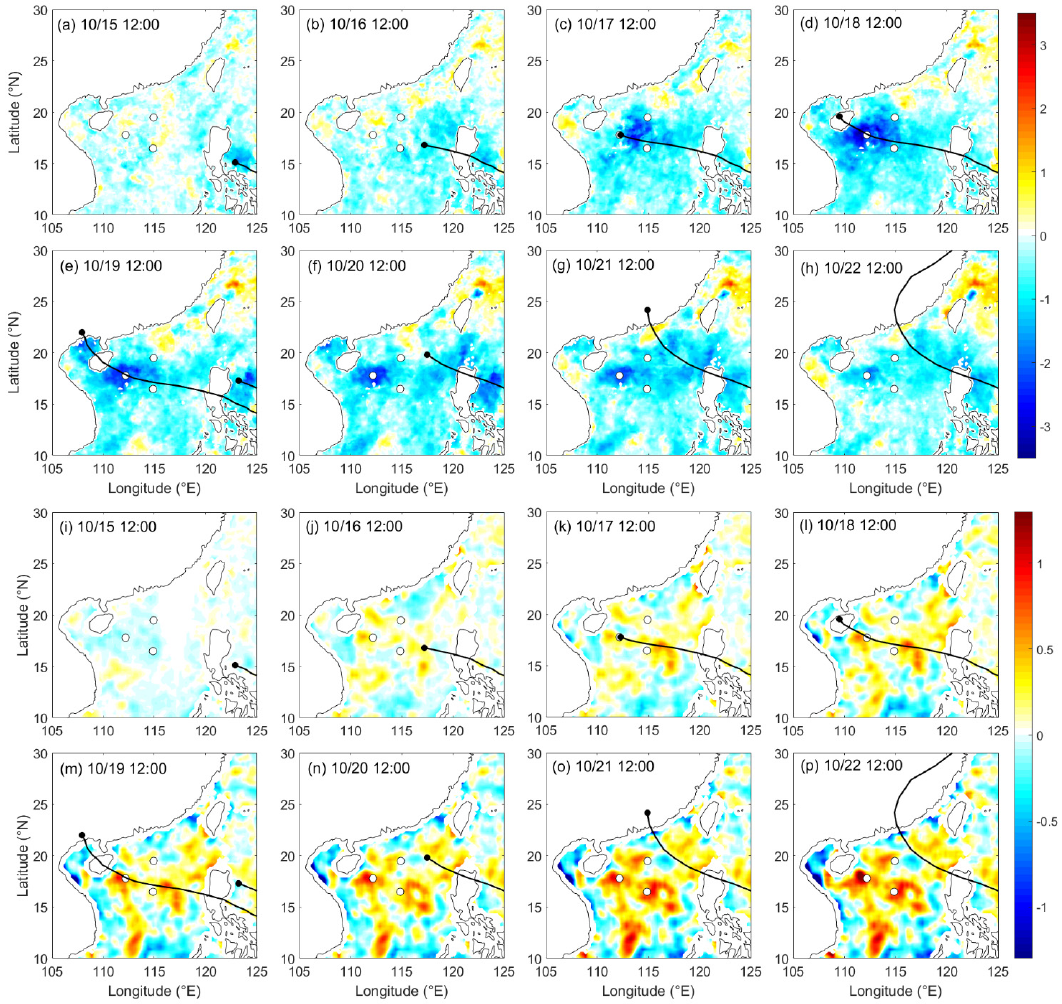
Figure 6. ( a – h ) Sea surface temperature and ( i – p ) sea surface salinity anomalies at 12:00 UTC between October 15 and 22. The anomalies are relative to the conditions at 12:00 UTC on October